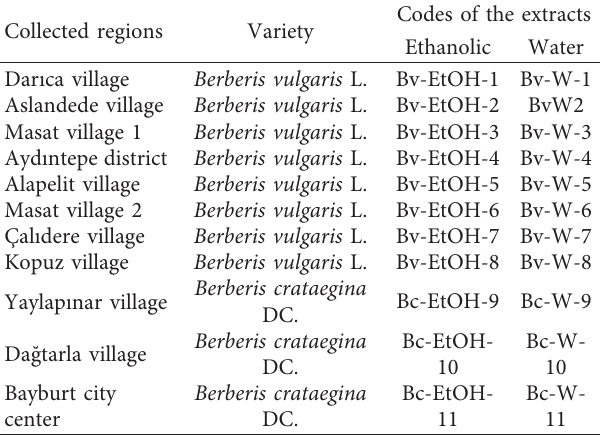
Table 1: Location, variety, and codes of the fruits used in the research. Collected